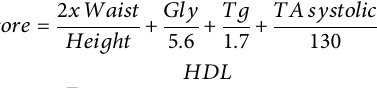
*Patients with glycoregulation impairment are excluded, therefore n =